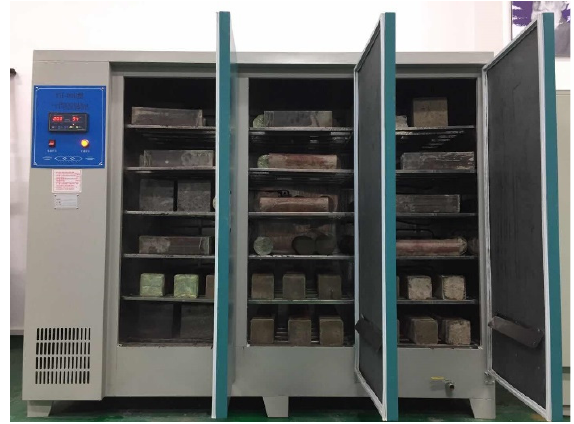
Figure 3. Constant temperature and humidity curing box.